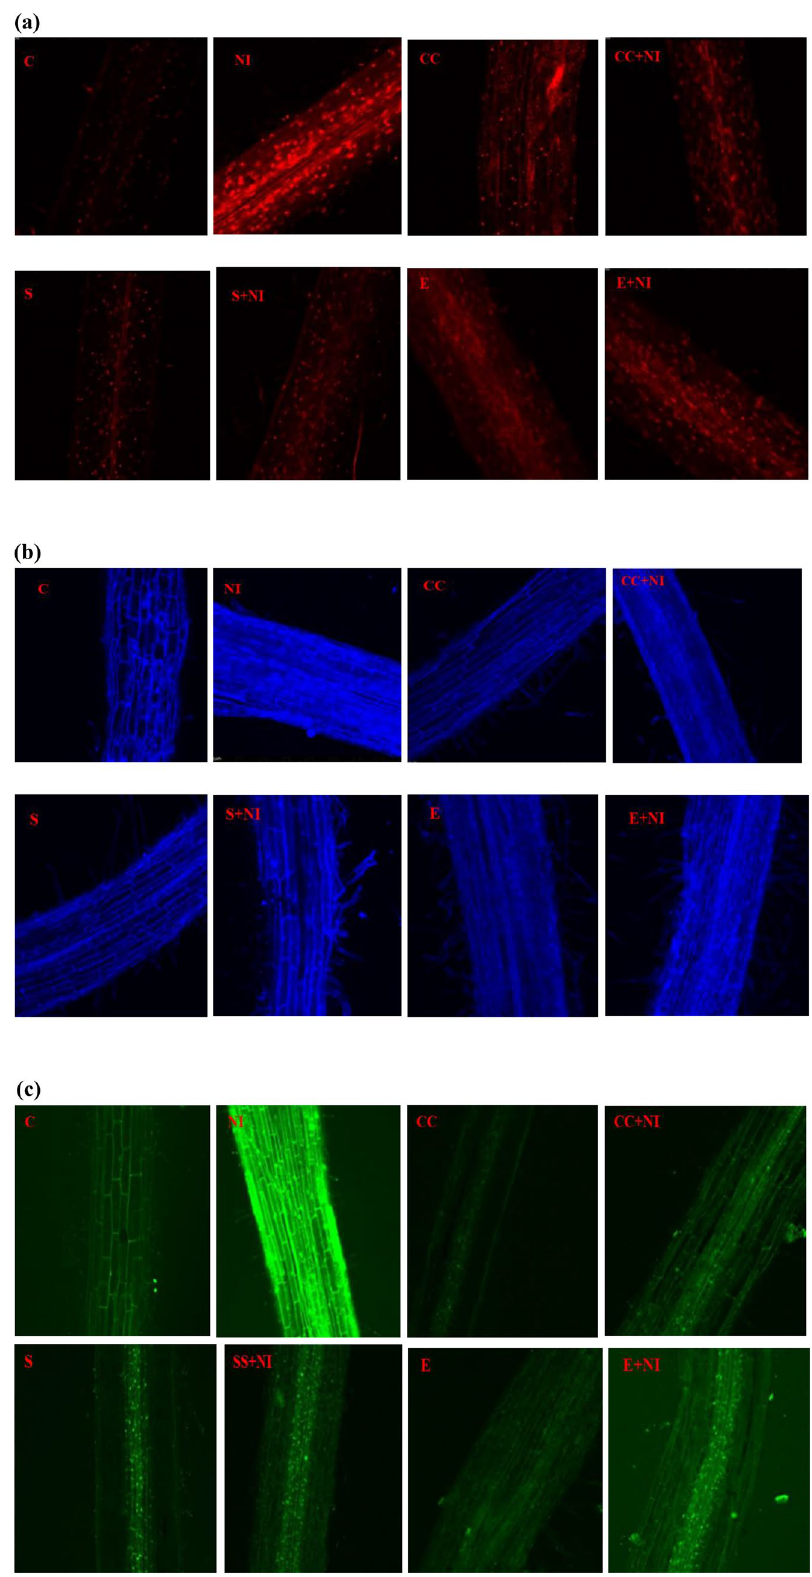
Figure 7. ( a–c ) Micrographs depicting ( a ) cell viability; ( b ) membrane damage; ( c ) hydrogen peroxide localization in differently treated S. lycopersicum seedlings. Different treatments are represented as C (control), NI (nematode inoculated); CC (culture cells); CC + NI (culture cells + nematode inoculated); S (supernatant); S + NI (supernatant + nematode inoculated); E (extract); E + NI (extract + nematode